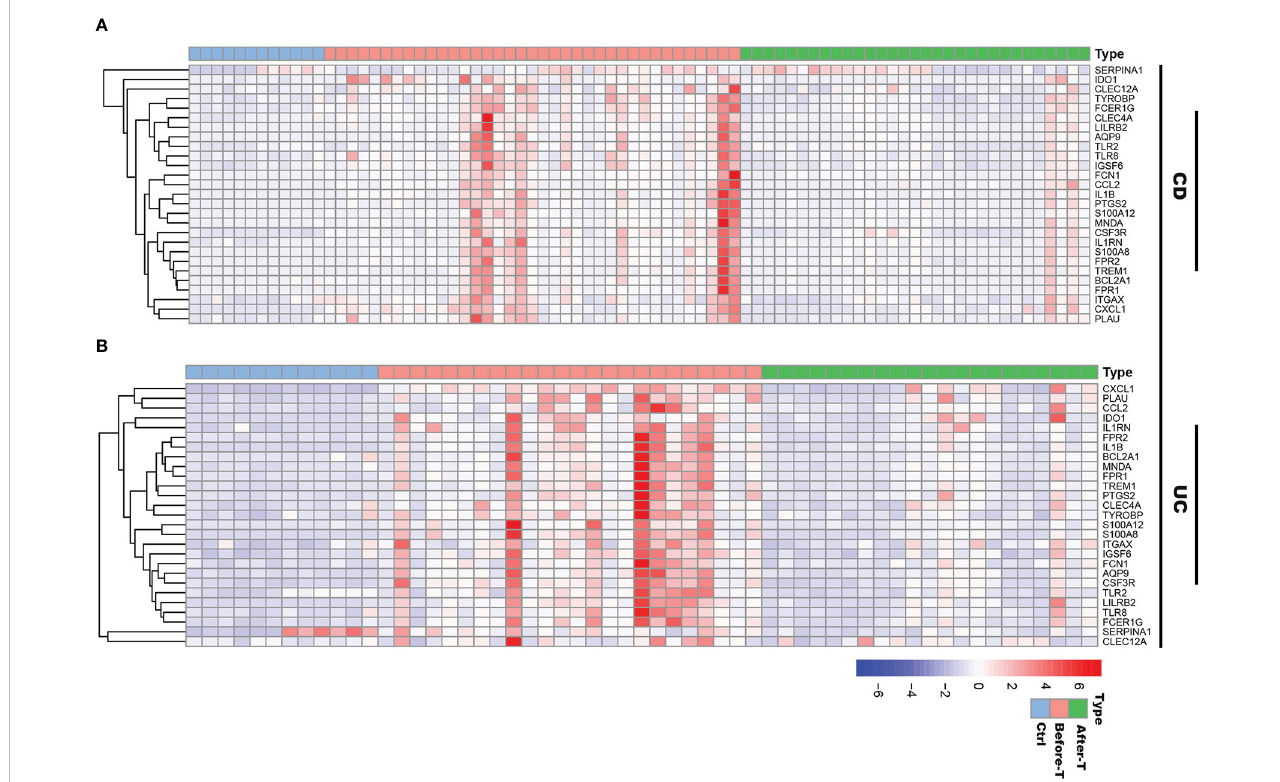
FIGURE 9 The expression pro fi les of IRGs in IBD patients before and after in fl iximab treatment. (A) Heatmap of the IRGs expression before and after in fl iximab treatment in CD patients, compared with healthy controls. (B) Heatmap of the IRGs expression before and after in fl iximab treatment in UC patients, compared with healthy